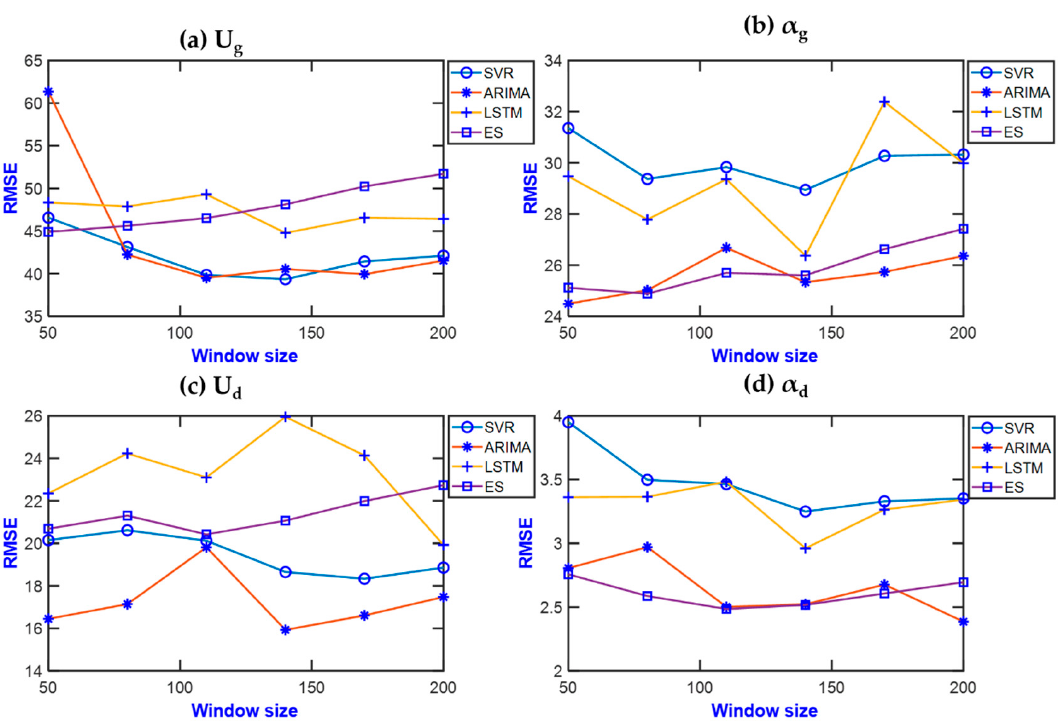
Figure 15. RMSE with variation of window size using sliding window method of ( a ) U g ( b ) α g ( c ) U d ( d ) α d .